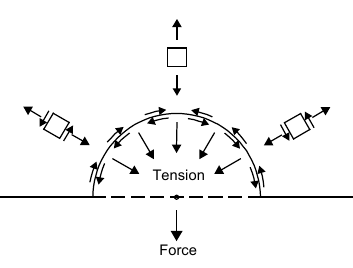
Figure 1. Scabbing-resistant energy ( E SC ).